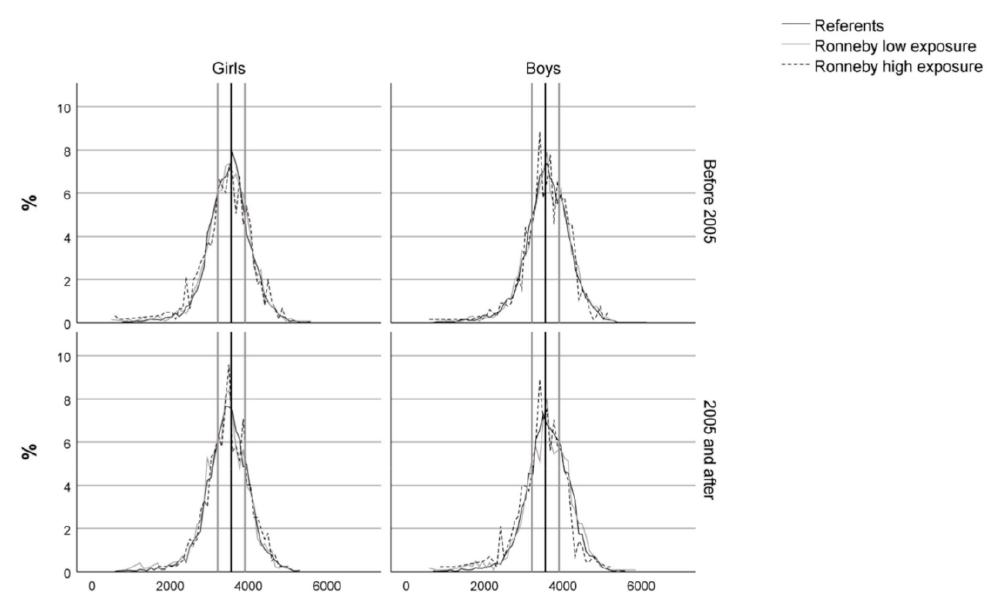
Figure 3. Distribution of birth weight stratified for infant sex and period (before or after 2005) for the different exposure groups. The black lines represent the median, and the surrounding grey lines represent